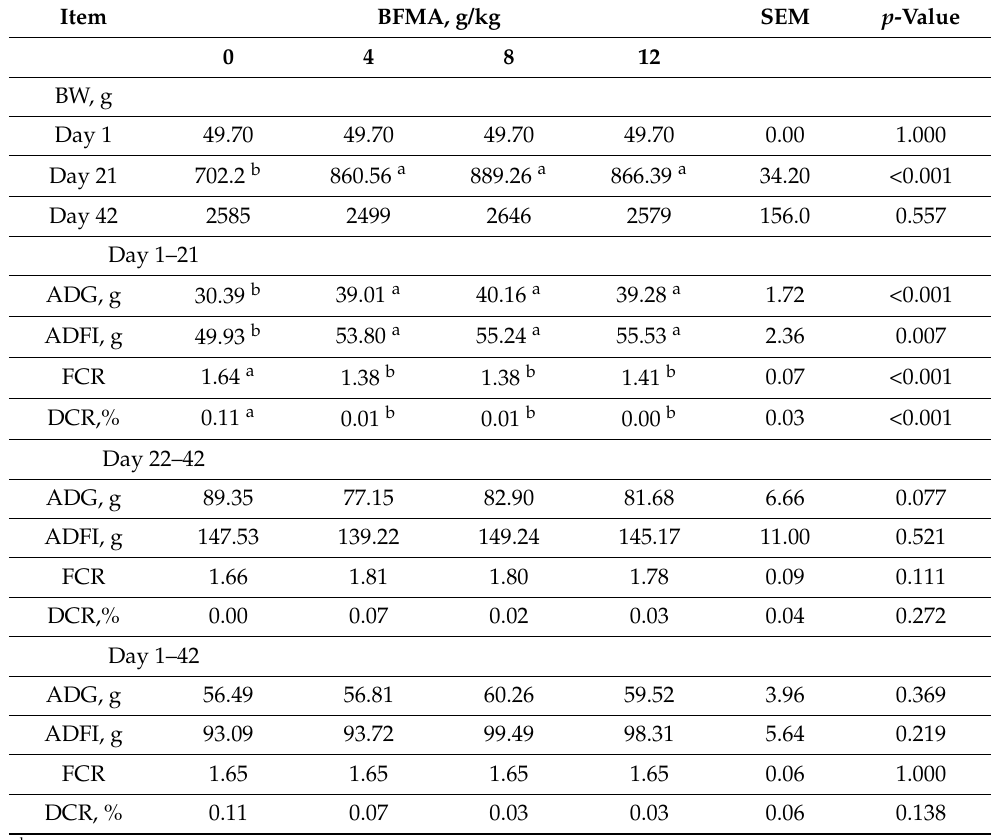
Table 2. Effects of dietary malic acid on the performance of broilers. Item